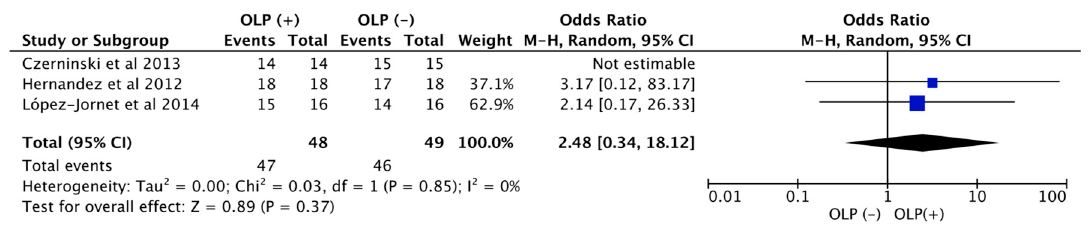
Figure 2. Meta-analysis forest plot. OLP, oral lichen planus.